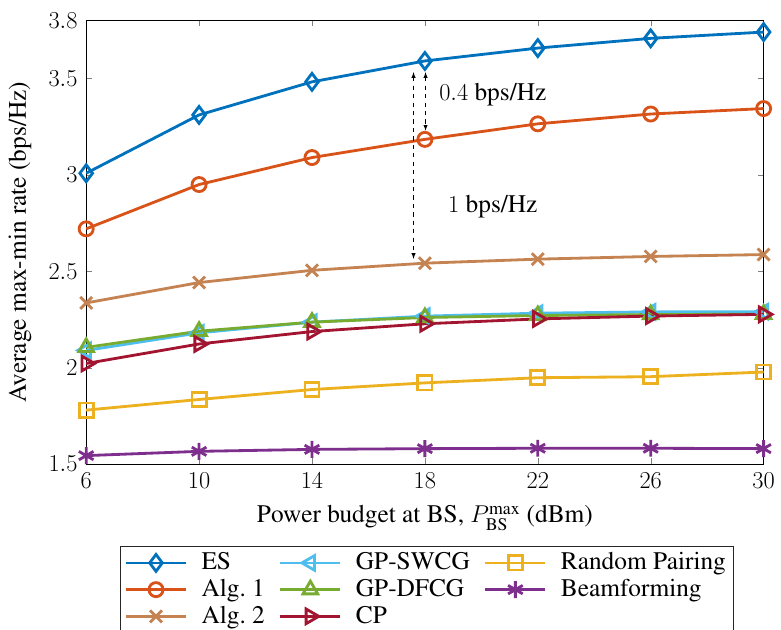
Figure 3. Average max-min rate versus power budget at